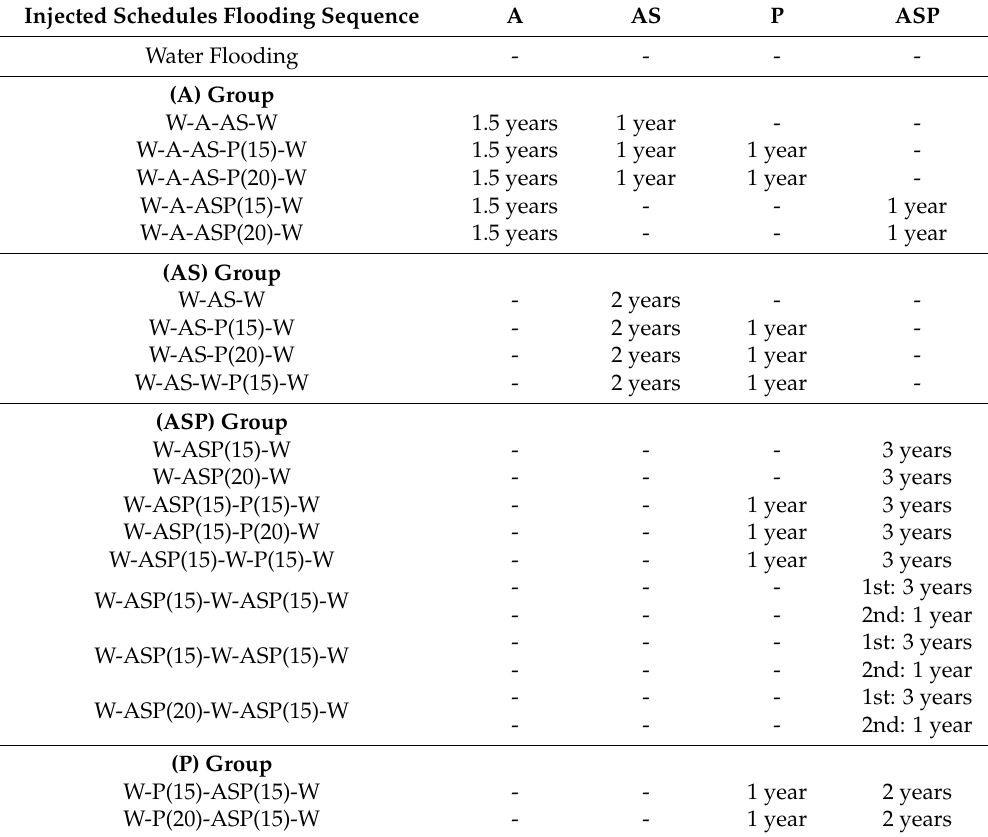
Table 2. Injection strategies of the flooding